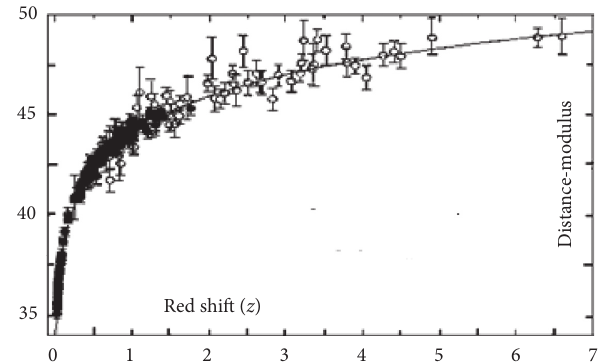
Figure 1: The recent Hubble diagram of 69 GRBs and 192 SNe